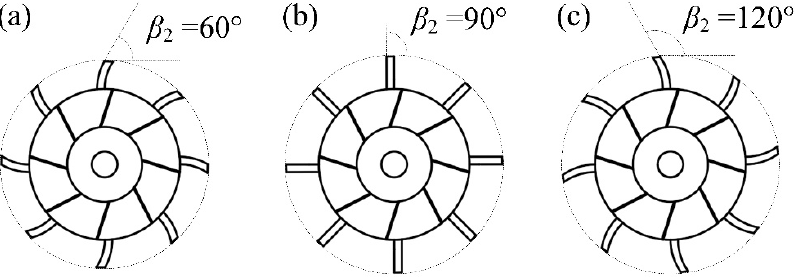
Figure 3. Schematic diagram of the setting angle of blade outlet β 2 . ( a ): β 2 = 60°, ( b ): β 2 = 90°, and ( c ): β 2 = 120°.